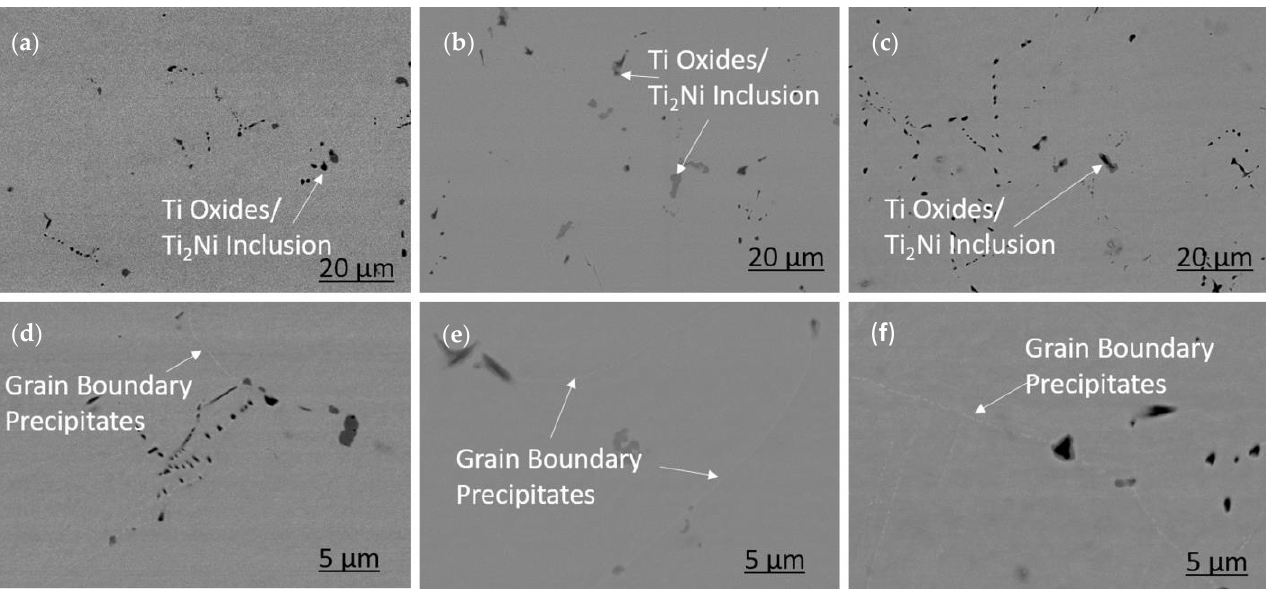
Figure 4. The microstructure of aged (550 °C × 3 h) group A VIM alloys: SEM micrographs of the ( a , d ) Ti-lean; ( b , e ) Ti50; and ( c , f ) Ti-rich alloys in two different magnifications.